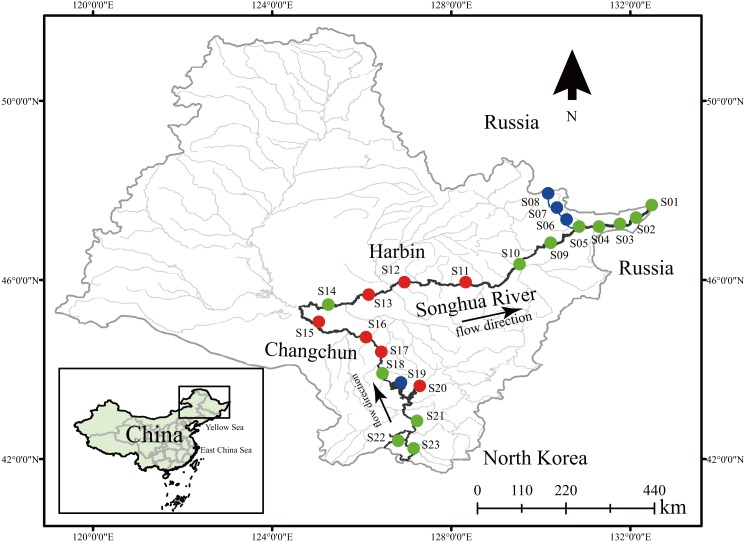
Sample locations of dinoflagellate communities along the Songhua River located in Northeast China.Dots in blue, red, and green represent sampling sites in Groups I, II, and III, respectively. All maps are made by ArcGIS version 10.0 (ESRI Company).